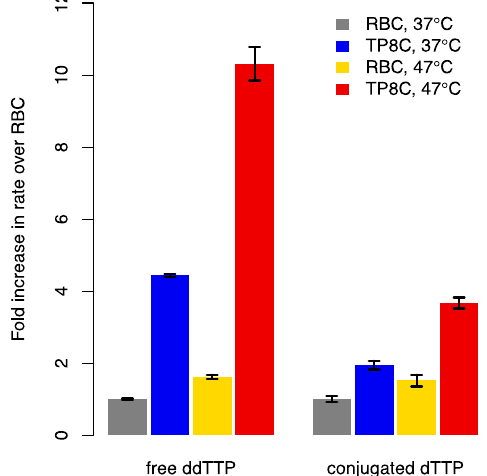
Figure 2. Optimizing the divalent cation concentrations and elevating the reaction temperature by 10 ◦ C synergistically increased the incorporation rates of free and conjugated nucleotides into a hairpin primer. Elongation of hairpin primer P5 by either free ddTTP and MTdT-evo or MTdTc302-evo-dTTP conjugates were performed in RBC and TP8C bu ff er at 37 ◦ C and 47 ◦ C. Elongation rates were normalized to rates in RBC at 37 ◦ C. Error bars correspond to mean ± SD of n = 3 independent replicates.